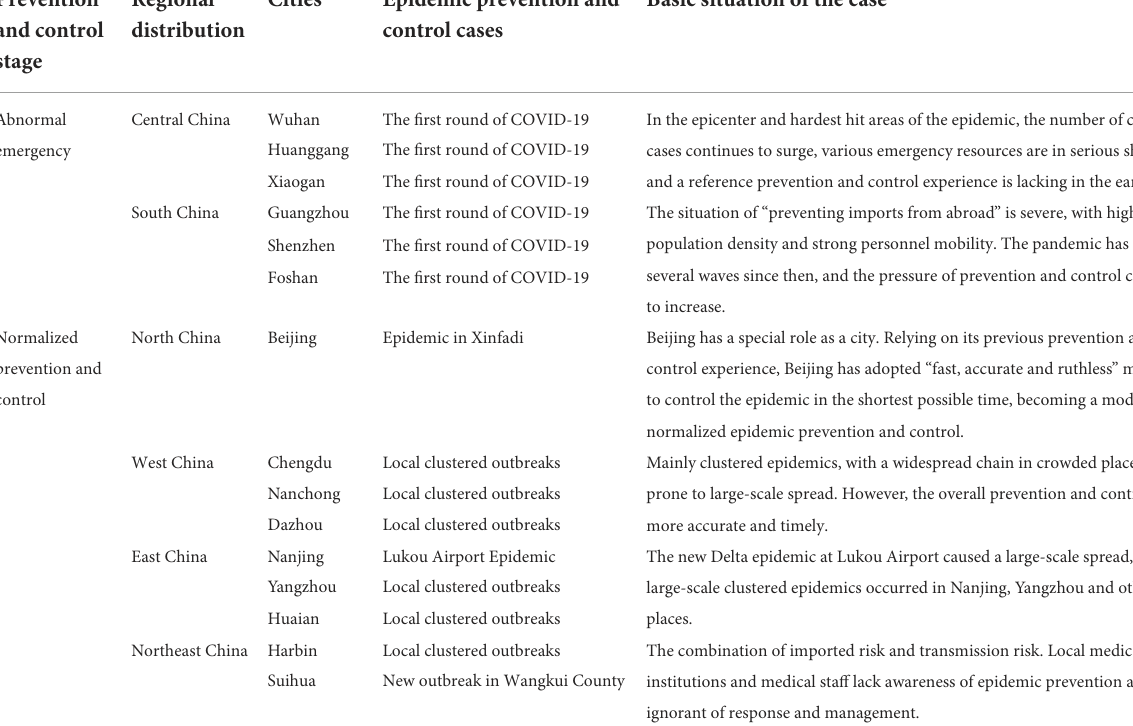
TABLE 1 Case selection and